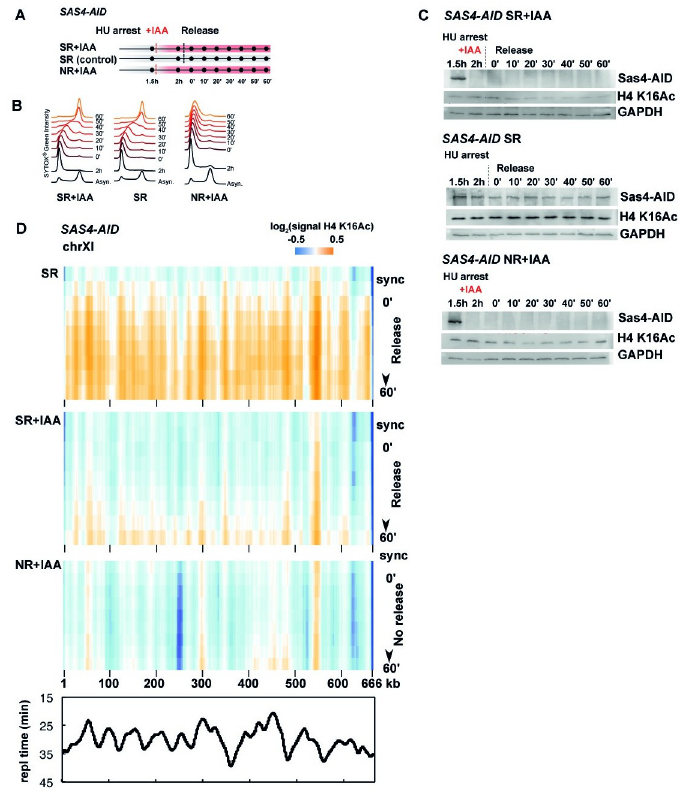
Fig 2. Replication-coupled acetylation of H4 K16 depends on the SAS-I histone acetyltransferase complex. (A) Experimental set-up to measure the dynamics of H4 K16Ac during S-phase. Cells were arrested in S-phase with HU for 1.5 hours; Sas4-AID was subsequently depleted by the addition of auxin (+IAA) for 30 minutes in the samples SR +IAA and NR+IAA (the solvent ethanol is added to the control experiment, SR). Cells of the SR+IAA and SR samples were then collected by centrifugation and resuspended in medium lacking HU. Samples were collected in 10 minute intervals and processed for FACS (B), Western blotting (C) and ChIP-seq (D). (C) Monitoring the depletion of Sas4-miniAID and H4 K16Ac in the synchronization/ release experiments. Blots were performed as in Fig 1A. Sync, synchronization. (D) Replication-associated dynamics of H4 K16Ac. The abundance of H4 K16Ac along chromosome XI is shown. Each plot gives the signal along the chromosome (horizontal) at the different times (vertical) relative to the average of the entire time-course. SR, Sas4-AID is on; SR+IAA, Sas4-AID is off; bottom, NR+AID, Sas4-AID is off, but cells were maintained in S-phase (“no release”, see A). Bottom, replication profile of chromosome XI as previously determined [26]. Replication time is plotted as a function of the